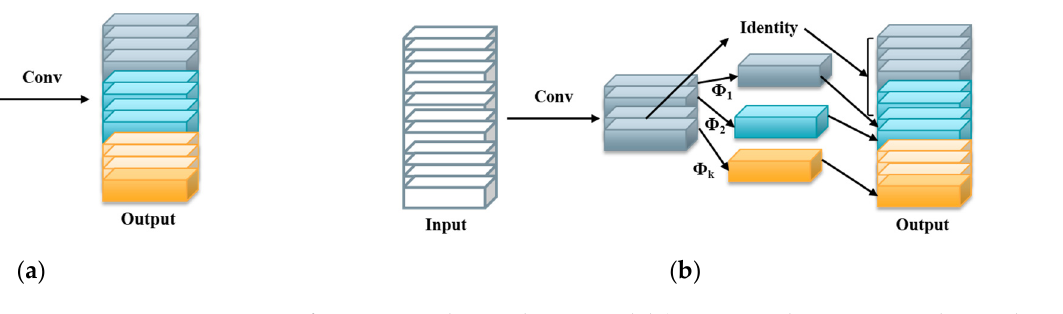
Figure 8. Structure of conventional convolution model (contains only conventional convolution operations) (a) and Ghostnet model (convolution operations include a small amount of convolution and channel-by-channel convolution) (b).